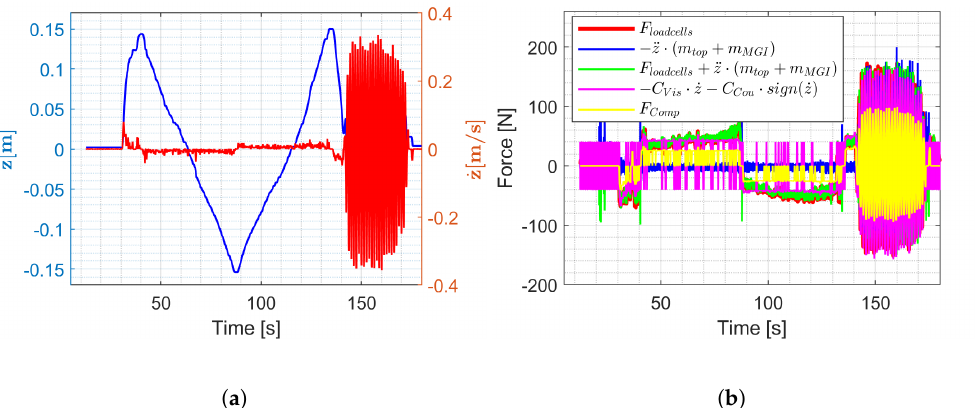
Figure 7. Friction characterization WEC with gearbox and motor ( a ) z and ˙ z time series (Test_054); ( b ) Force time series